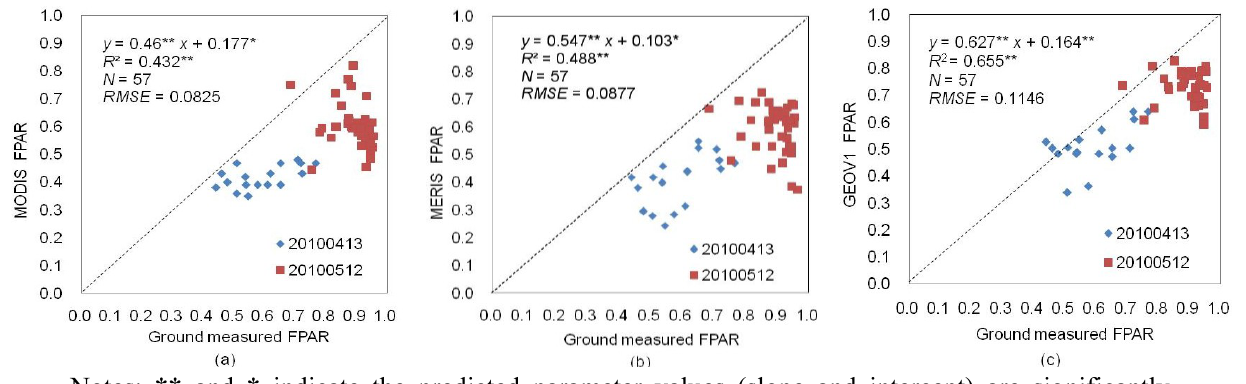
Figure 3. Validation of winter wheat FPAR products based on